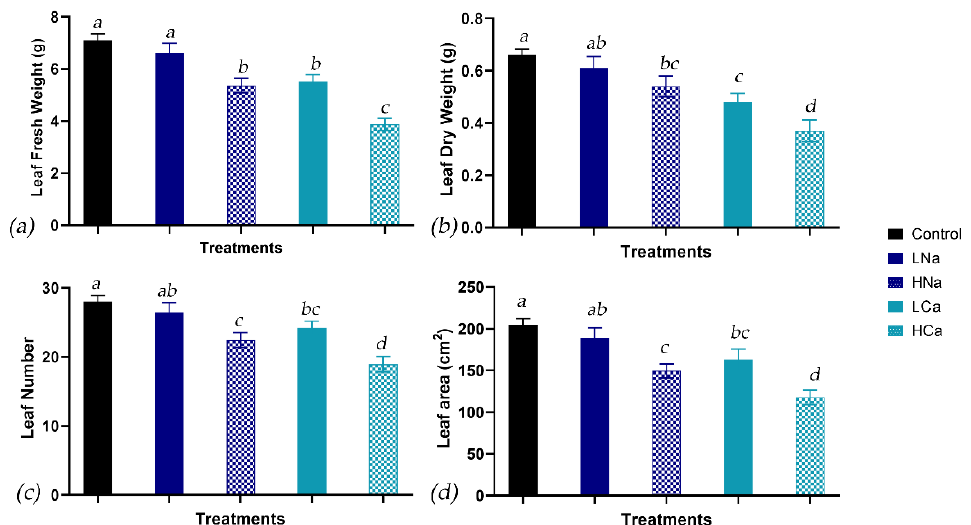
Figure 1. ( a ) Leaf fresh weight (LFW), ( b ) leaf dry weight (LDW), ( c ) leaf number (LN), and ( d ) leaf area (LA) in Valerianella locusta plants grown in a floating system, as influenced by four salinity treatments (referred to as low and high salinity level) and the salinity source. Control: standard nutrient solution ( − 0.08 MPa, 20 ◦ C); LNa: low NaCl-salinity ( − 0.18 MPa, 20 ◦ C); HNa: high NaCl- salinity ( − 0.28 MPa, 20 ◦ C); LCa: low CaCl 2 -salinity ( − 0.018 MPa, 20 ◦ C); HCa: high CaCl 2 -salinity ( − 0.28 MPa, 20 ◦ C). Vertical bars indicate ± standard errors of means of three measurements. Same letters indicate non-significant differences at p ≤ 0.05 according to Duncan’s multiple range